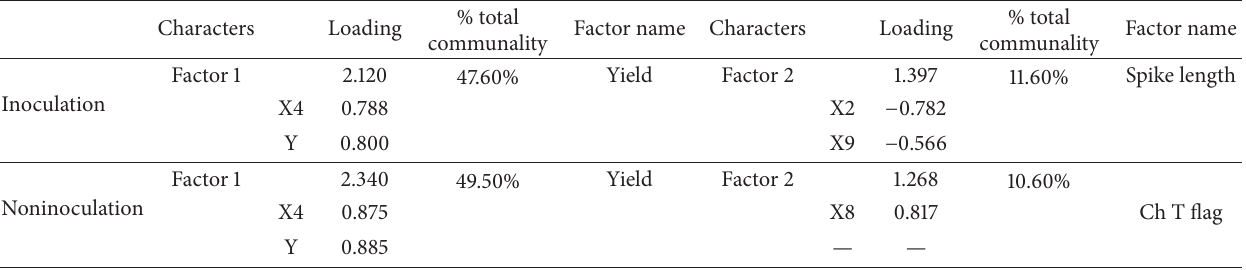
Table 9: Summary of factors loading for the estimated variables of wheat with mycorrhiza inoculation or noninoculation under different water